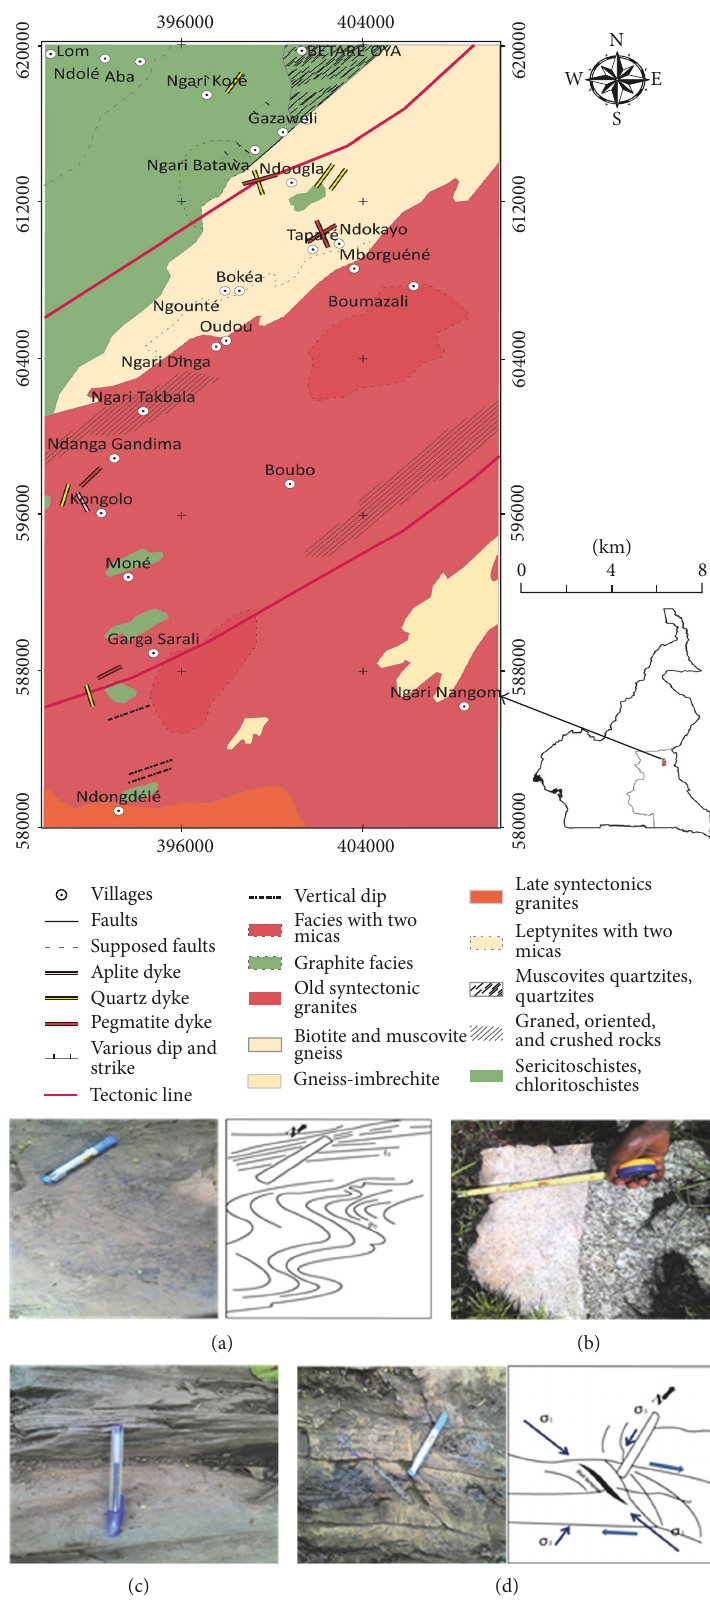
Figure 3: Geological map of the study area (reproduced and modified from Gazel et al., 1954, under the public domain) with AMT soundings points; field observation showing folds on a schist (a); porphyritic granite (b); schistosity (c); joint tension/dextral shear in granite